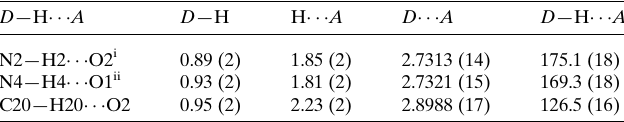
Table 1 Hydrogen-bond geometry (A˚ , (cid:3) ).